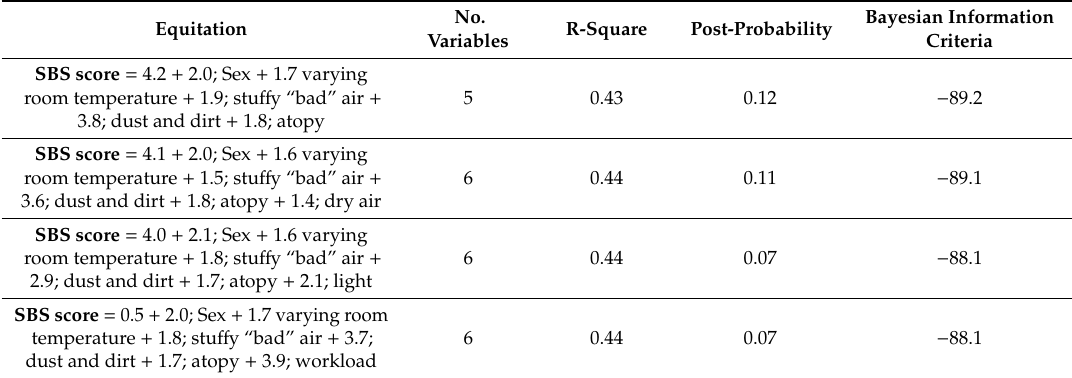
Table 4. Four optimal models were chosen through the Bayesian model average method. Equitation